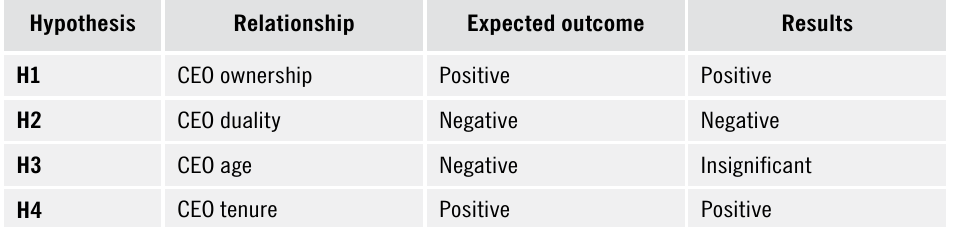
Table 12. Results summary of study